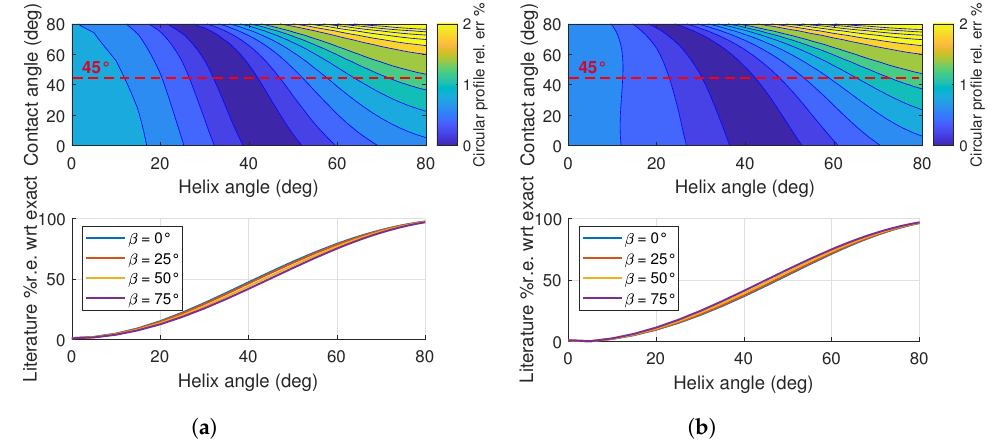
Figure 9. Relative errors committed by using the Eureqa solution (upper graphs) and the literature formula (lower graphs) on the first principal curvature radius of the ( a ) screw shaft and ( b ) nut grooves depending on the pitch circle radius and the helix angle, for a ball screw with r m = 8 mm, r b = 1.5875 mm, H = 0.0629 mm and L = 0.0505